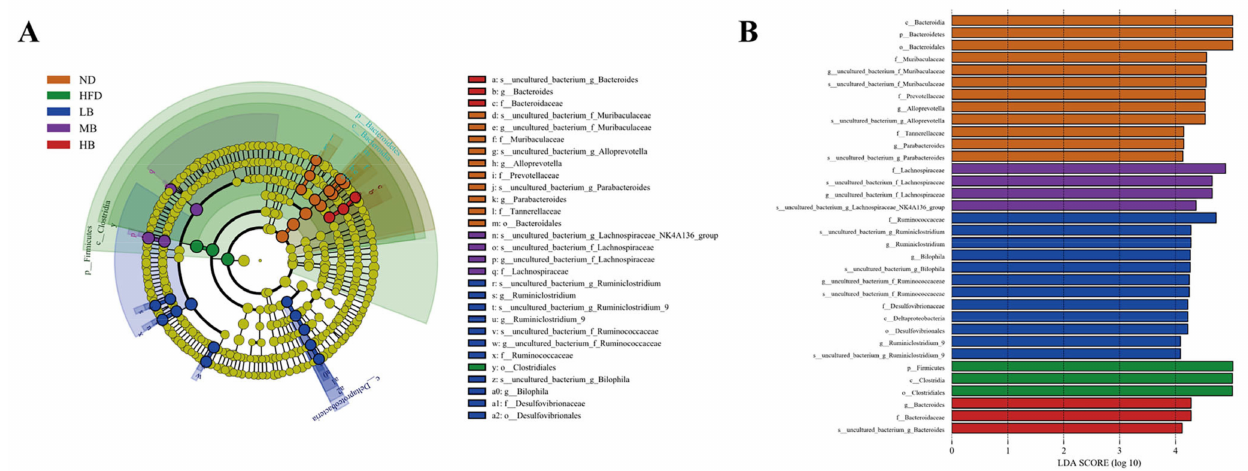
Figure 6. Linear discriminant analysis (LDA) effect size (LEfSe) used to identify the dominant microbial taxa. ( A ) Branch diagram depicting the output of the LEfSe analysis. ( B ) LDA (log10 >